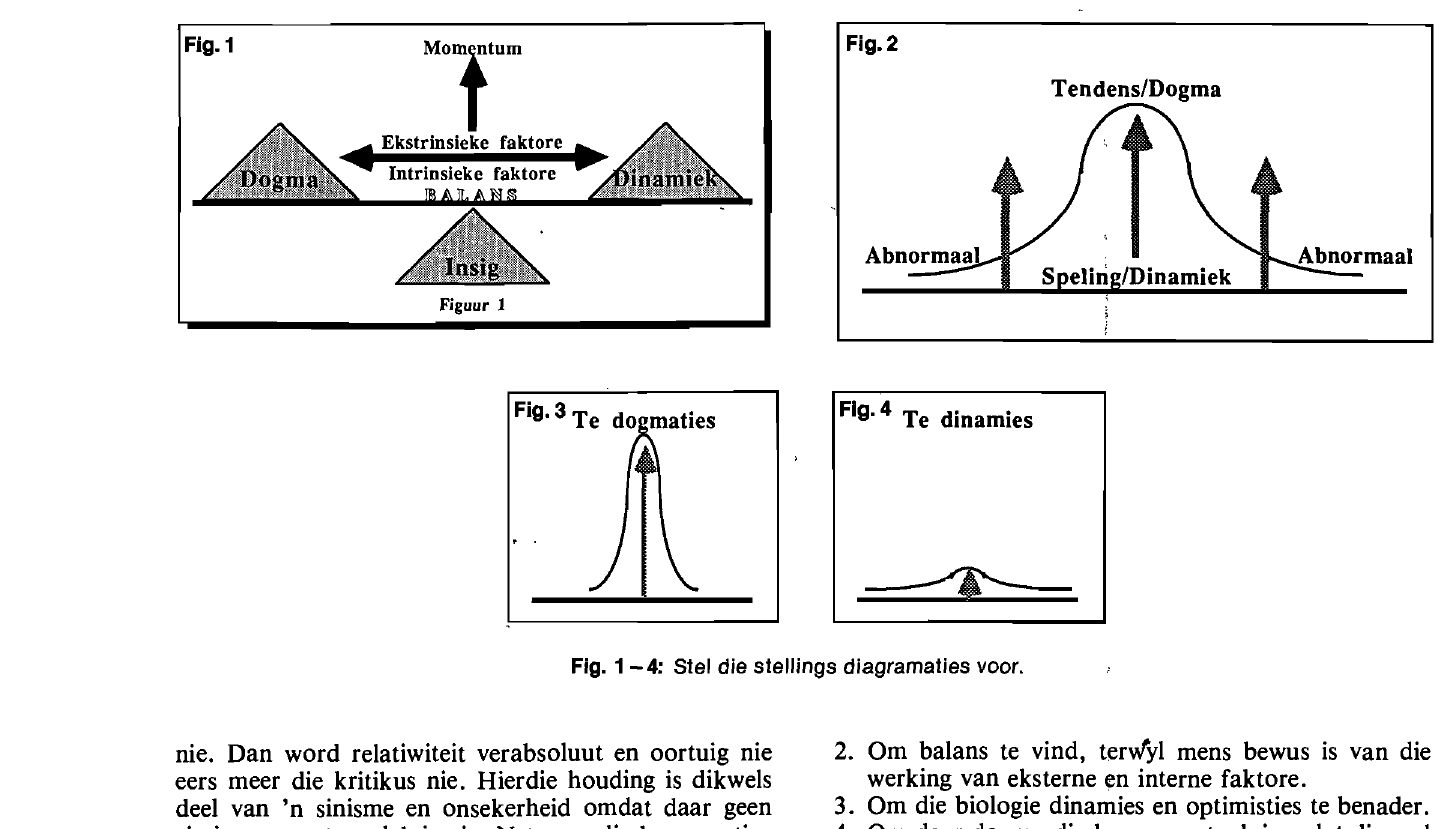
Fig. 1 -4: Stel die stellings diagramaties